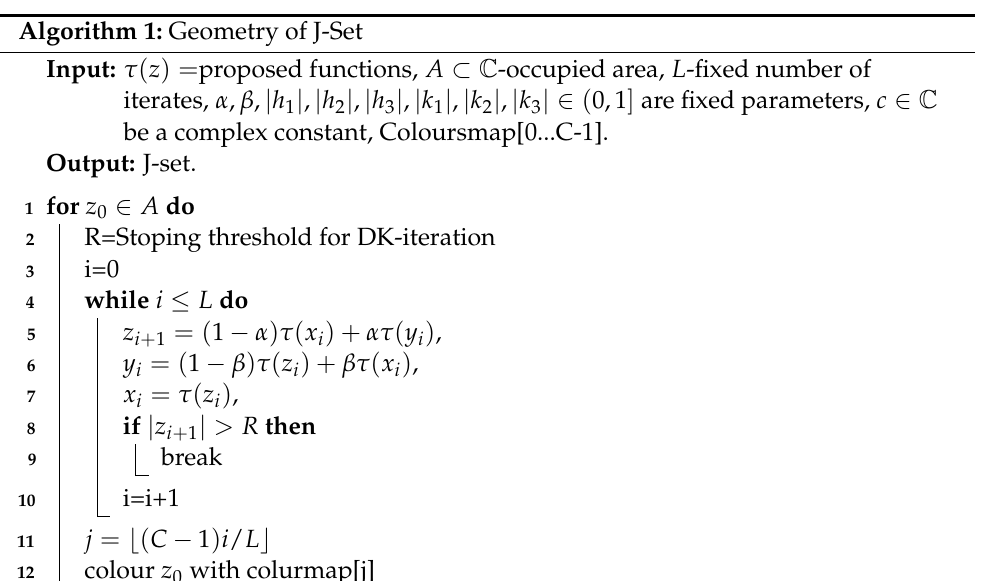
Algorithm 1: Geometry of